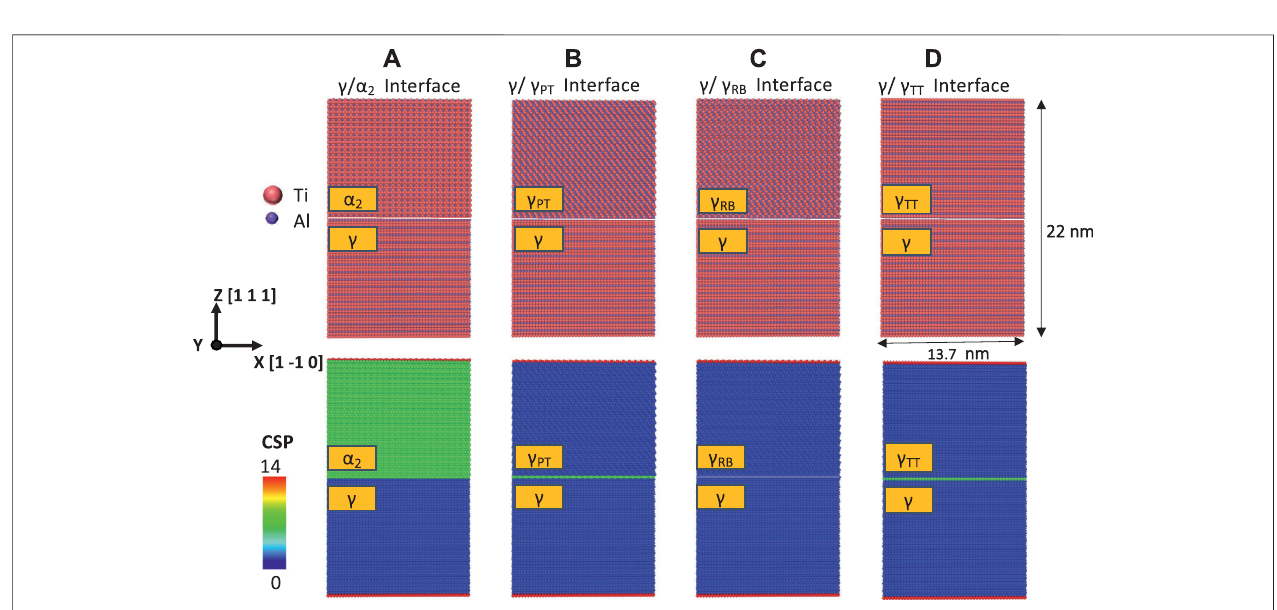
FIGURE 2 | First row: simulation system for the defect-free interfaces ( (A) c / α 2 , (B) c / c PT , (C) c / c RB , and (D) c / c TT ) after energy minimization. Second row: computed centrosymmetry parameter (CSP) to categorize the bulk constituent phase and interface. Here, atoms with blue color code: γ ; green color code: either the interface or α 2 phase; red color code: surface